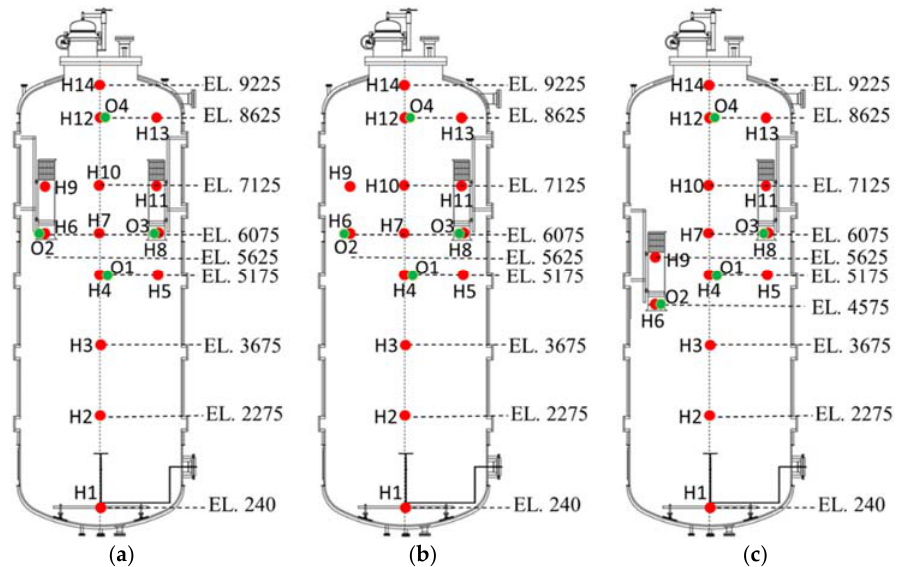
Figure 7. Measurement points of hydrogen and oxygen concentrations for SAPRC ‐ PAR experiment, O: oxygen sensor and H: hydrogen sensor. ( a ) 2 PARs in parallel; ( b ) 1 PAR; ( c ) 2 PARs staggered.